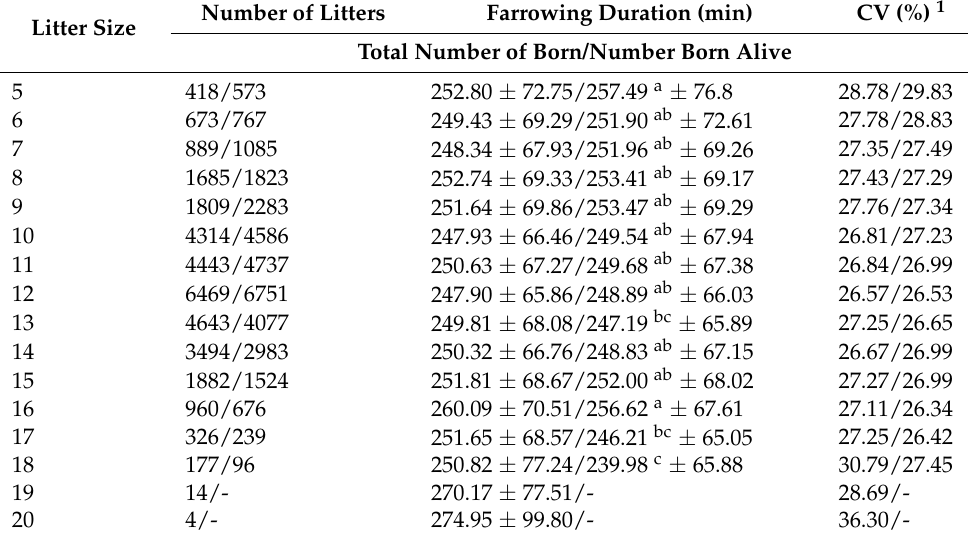
Table 2. Descriptive statistics of farrowing duration of different total number of born and number born alive